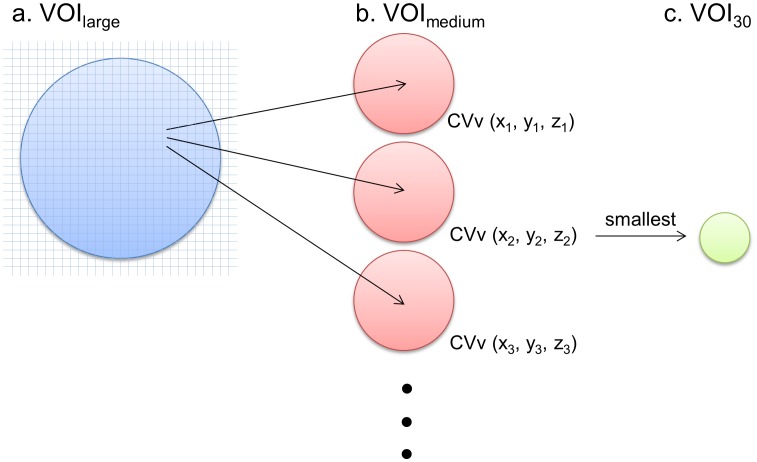
An illustration of the algorithm.(a) The spherical VOIlarge confines the search area. (b) The spherical VOImedium is defined for each pixel in VOIlarge to calculate CVv ( =  standard deviation / mean). (c) VOI30 (sphere of 30-mm in diameter) is placed where CVv is smallest. The tumor delineation threshold is defined by the mean and SD within VOI30.